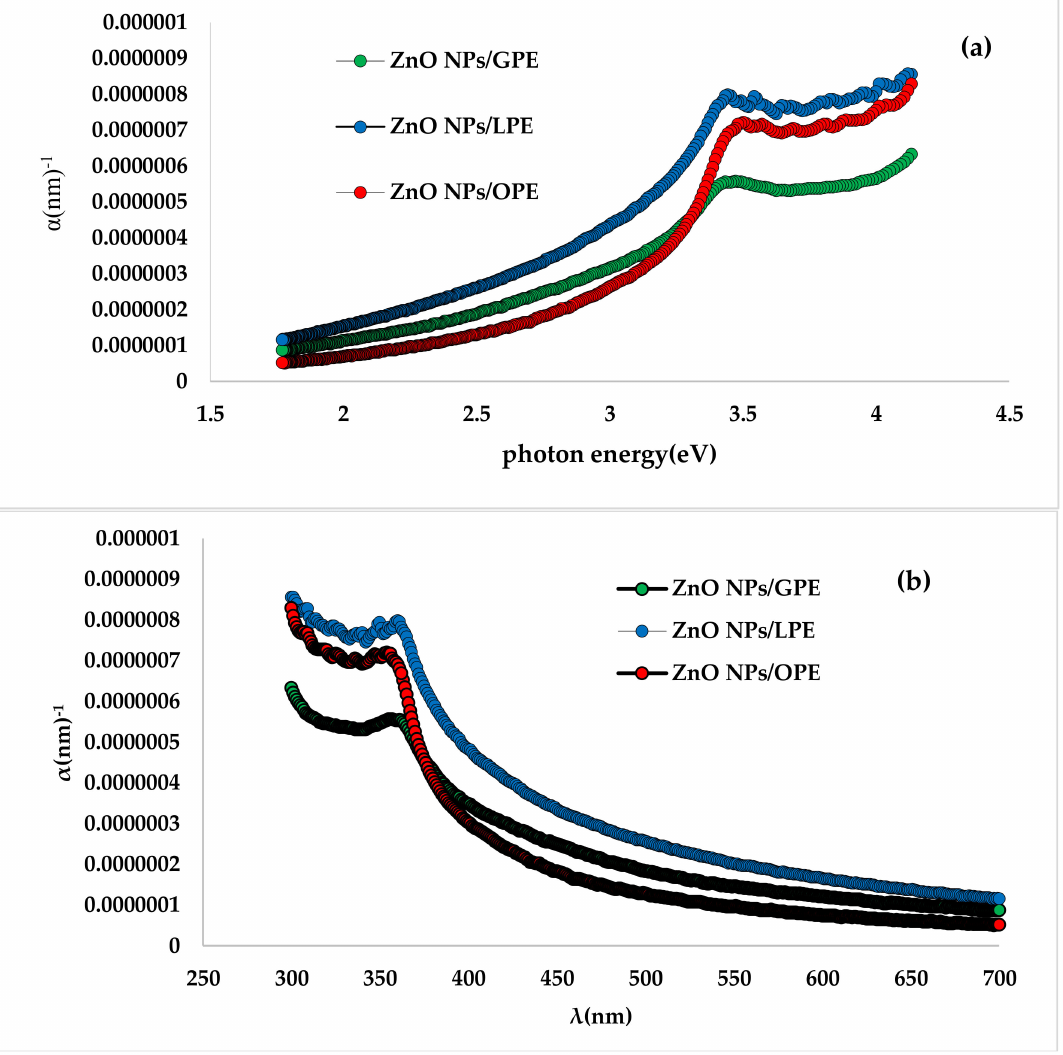
Figure 3. Dependence of the absorption edge on ( a ) photon energy (h) and ( b ) wavelength ( λ